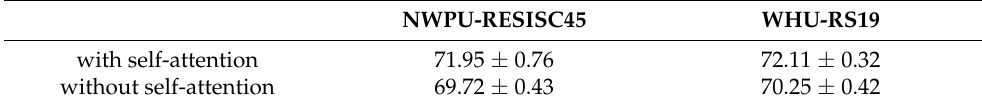
Table 4. Classification accuracy of 5-way 1-shot on WHU-RS19 and NWPU-RESISC45 datasets.